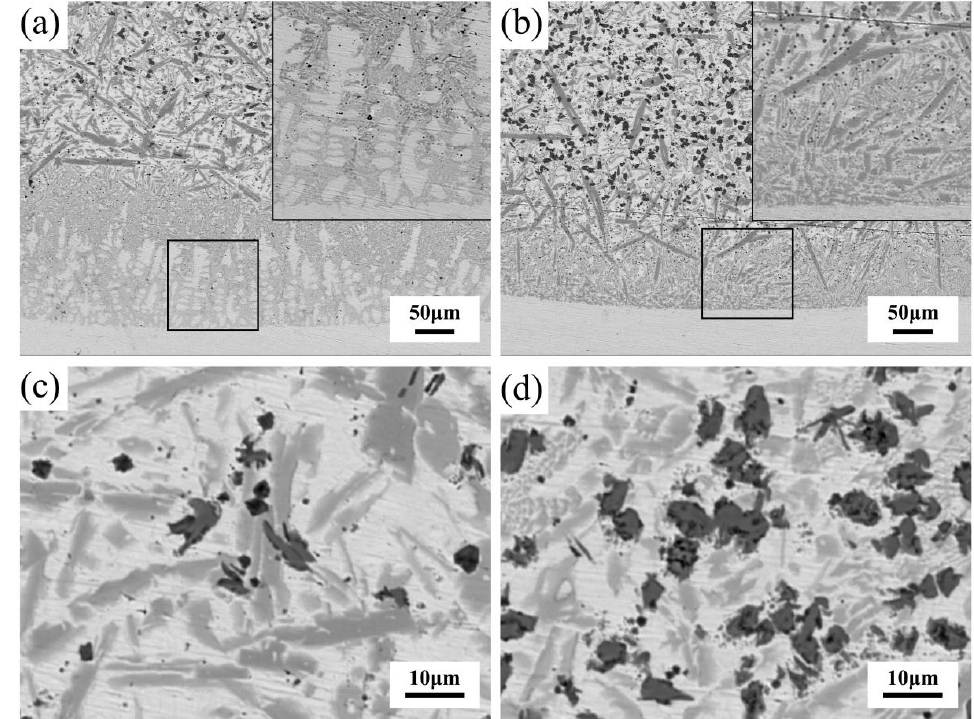
Figure 6. SEM images of the coatings from the cross section: ( a ) the interface between TN10 and H13 substrate; ( b ) the interface between TN15 and H13 substrate; ( c ) the magnified image of the uniform microstructure in the upper-middle part of TN10; ( d ) the upper-middle part of TN15 with uniform microstructure.